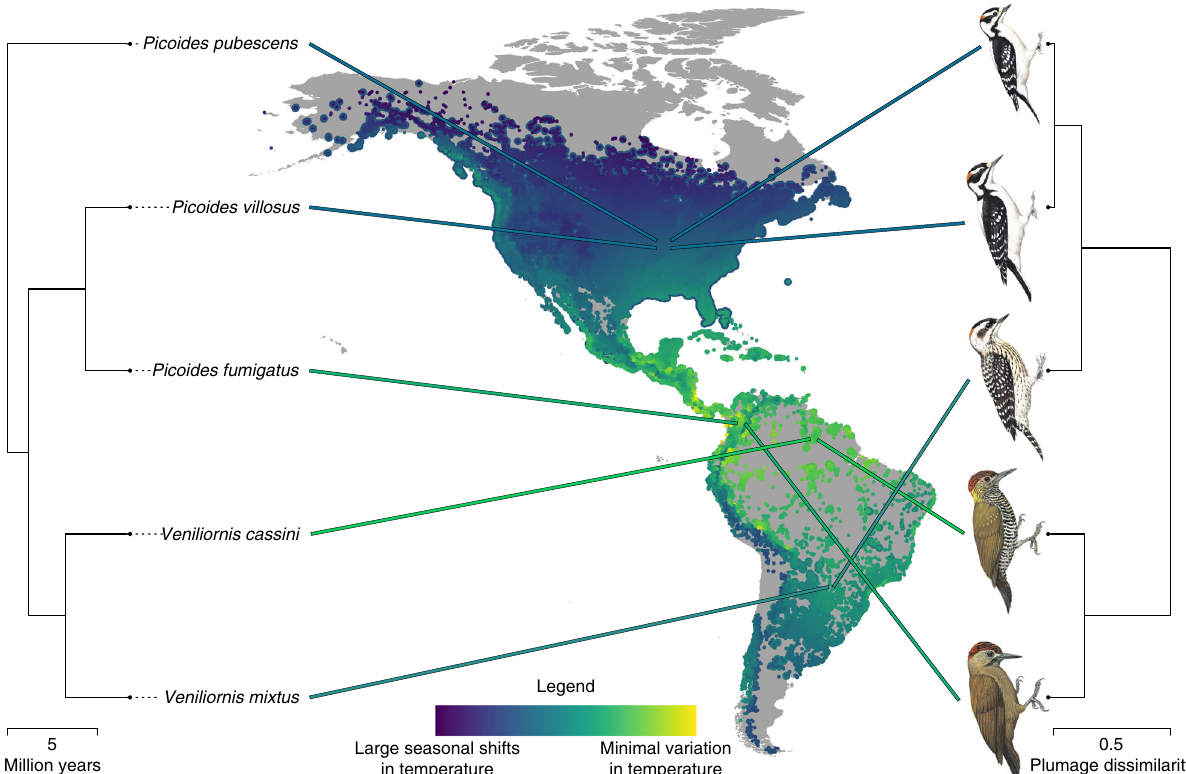
Fig. 1 Evolutionary relationships and plumage similarity among exemplar species. Climate partially determines variation in woodpecker plumage. Lines lead from tips of phylogeny (left) to centroid of each species ’ geographic distribution and are coloured according to mean climate regime of each species. These species shared a common ancestor ~ 6.5 mya. The colour scale depicts a gradient from warm (yellow) to seasonally cold regions (blue). eBird records for these species are plotted in the same colours as large points on the map. All other eBird woodpecker records are overlaid as smaller points and coloured similarly. Plumage dendrogram (right) shows the plumage dissimilarity relationships among the same set of species. Veniliornis mixtus , long classi fi ed as a member of Picoides , is inferred to have invaded seasonal climates in the southern hemisphere, and accordingly evolved bold black and white plumage. Picoides fumigatus , long classi fi ed as a member of Veniliornis , is inferred to have invaded warm climates near the equator, and accordingly evolved dark, subtly marked plumage. Picoides pubescens and P. villosus are rather distantly related but largely sympatric; they are inferred to have converged on one another in plumage above and beyond what would be expected based on shared climate, habitat, and evolutionary history. Traditional scienti fi c names are used in this fi gure to aid explanation, but the illustrated species are currently all members of an expanded clade, Dryobates . Illustrations © HBW